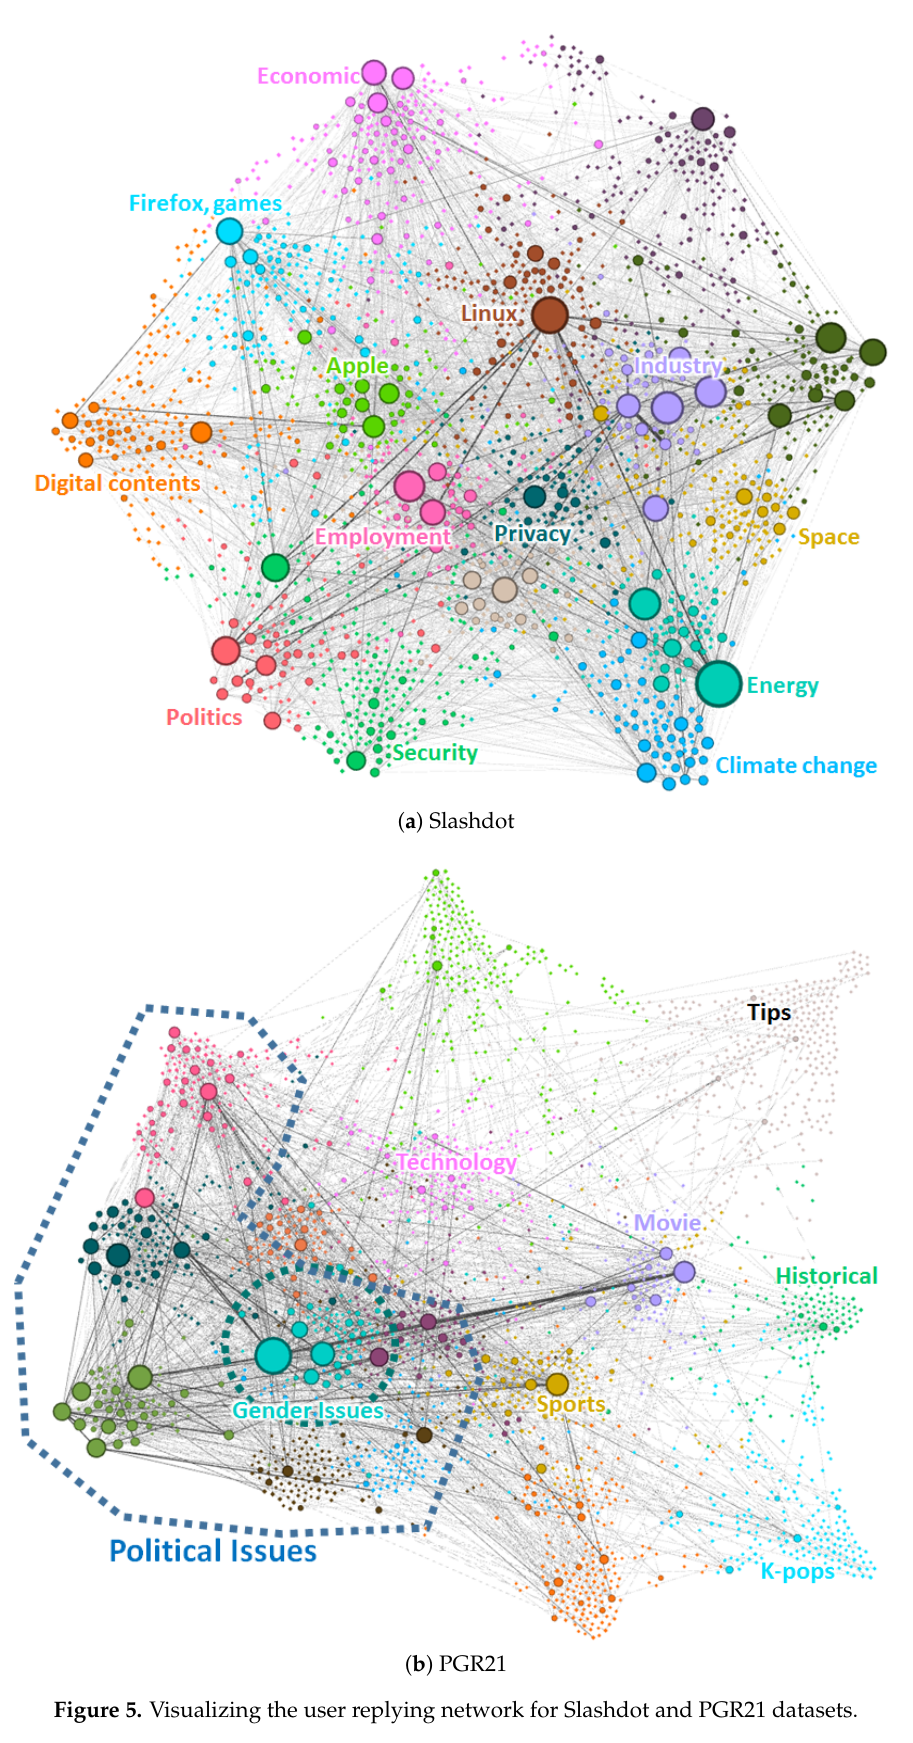
Figure 5. Visualizing the user replying network for Slashdot and PGR21